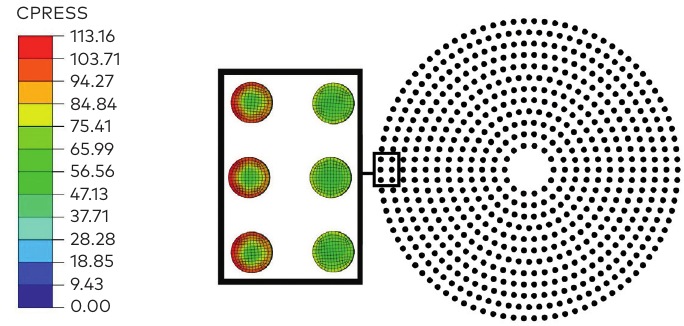
Figure 11. Stress distribution of the rotating mechanism with slide